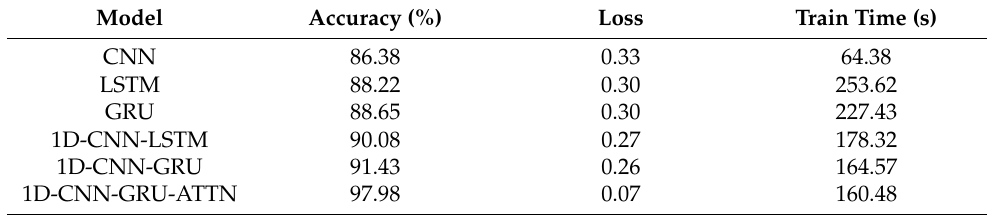
Table 8. The accuracy, loss, and time of private dataset on different models. Model